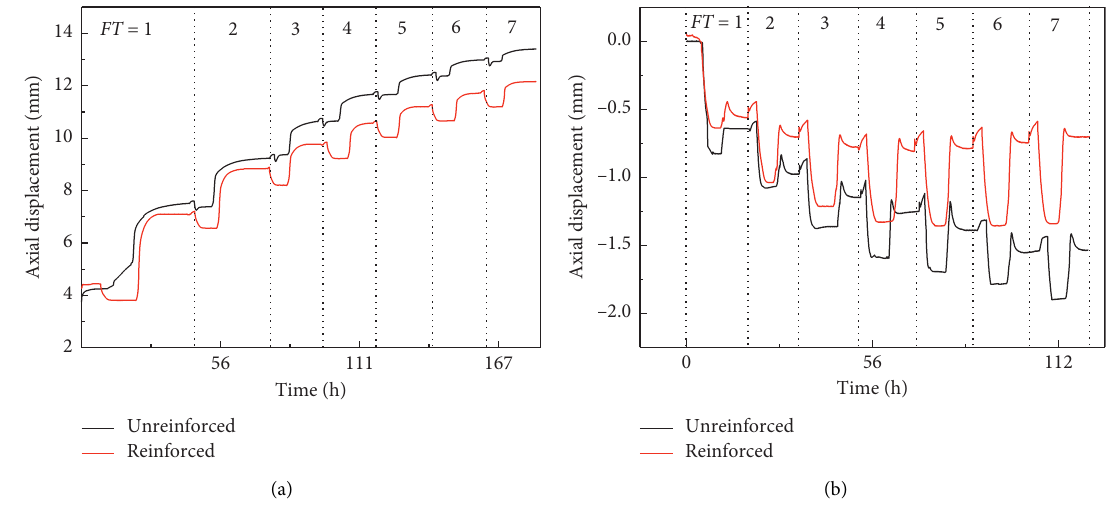
Figure 6: Axial displacement curves of soil samples under freeze-thaw cycle ((a) confining pressure of σ σ 3 � 10kPa).